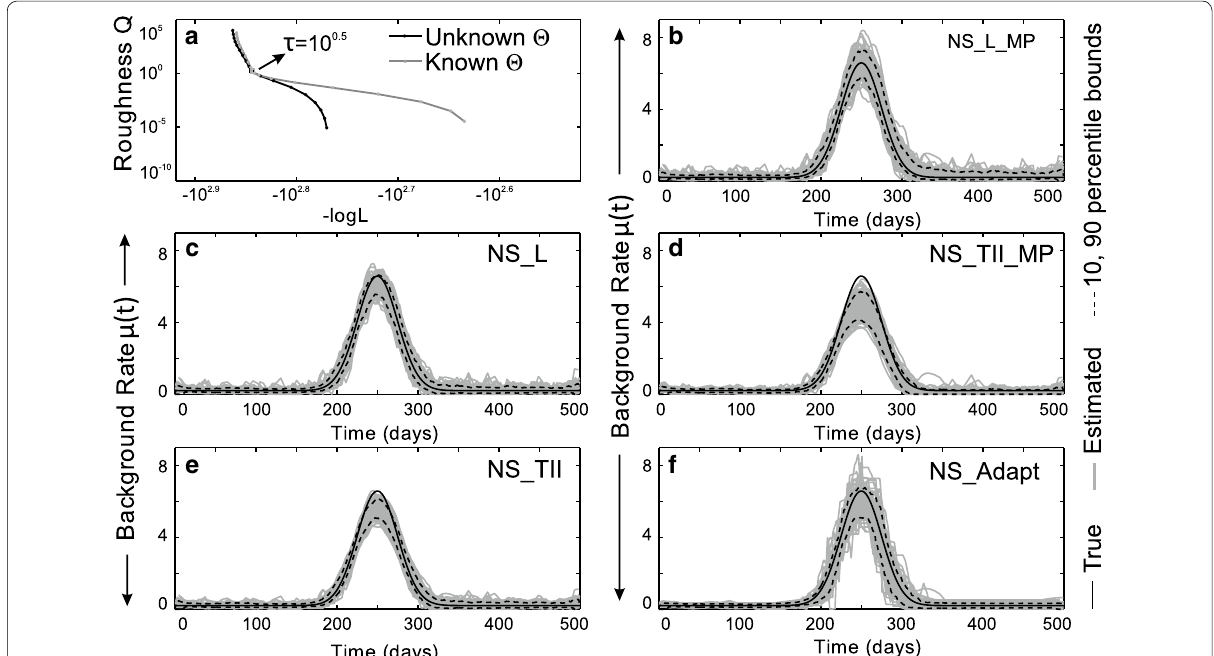
Fig. 1 Results for the synthetic datasets simulated with a Gaussian background rate function. The L-curves computed for one typical synthetic data- set along with the point corresponding to the chosen optimal smoothness parameter are shown in ( a ). The estimated background rate function for all 100 synthetic catalogs for each type of model listed in Table 1 is presented in ( b - f ). The true background rate function and the 10, 90 percentile bounds of estimates for each model are also